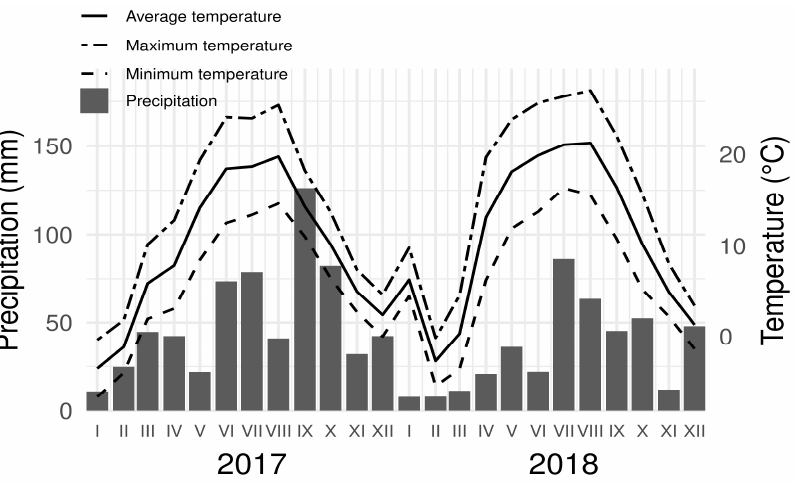
Figure 1. Average monthly air temperatures and precipitation during research years (2017–2018). Table 1. Chemical properties of raw slurry and acidified